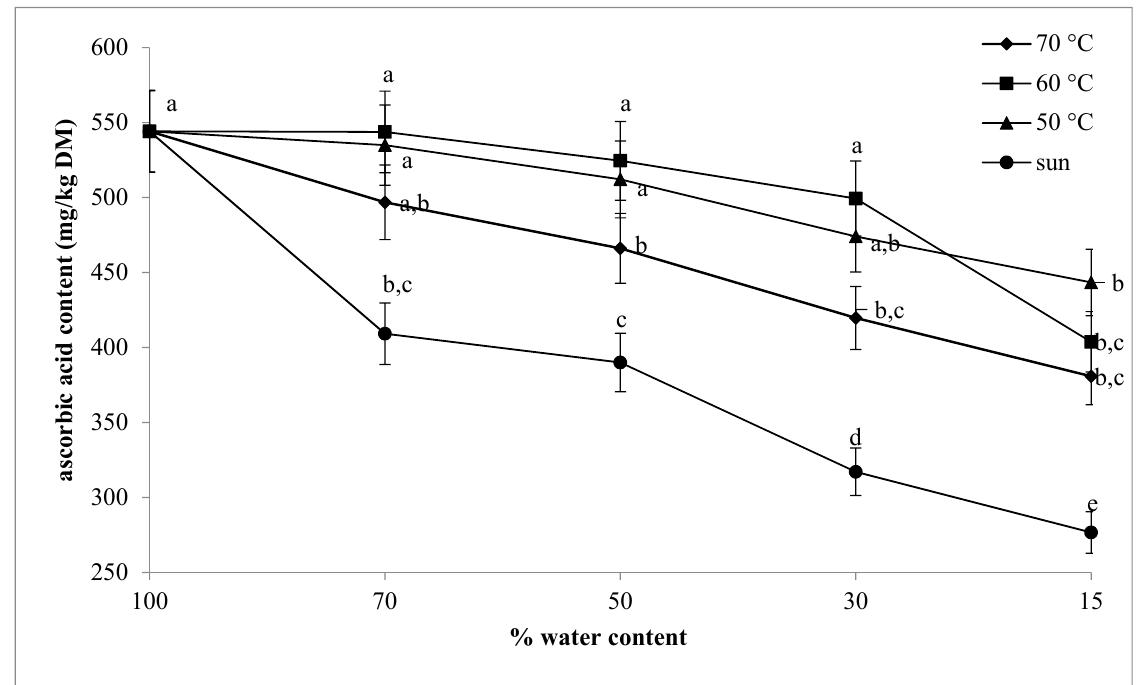
Figure 3. Ascorbic acid content with different drying conditions. Data points with different letters are statistically different by Tukey’s test at α =0.05.